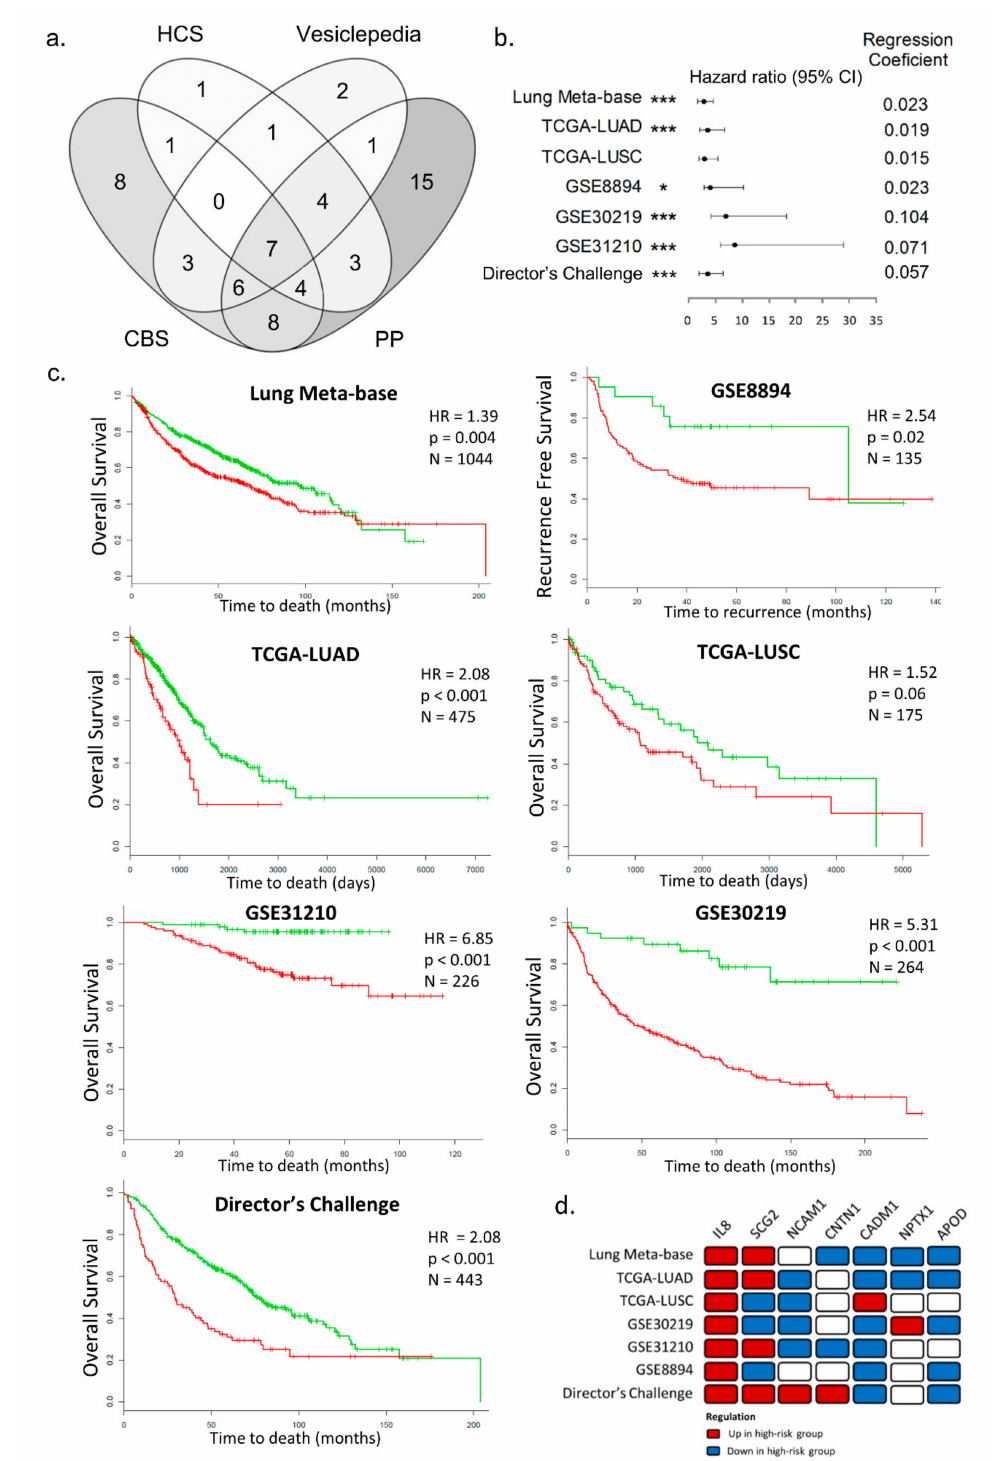
Figure 4. Prognostic values of the potentially secreted proteins in tumors from patients with low-muscularity. ( a ) The intersection of databases used for prediction of secreted proteins revealed seven overlapped proteins: interleukin-8 (IL-8), SCG2, NCAM1, CNTN1, CADM1, NPTX1, and